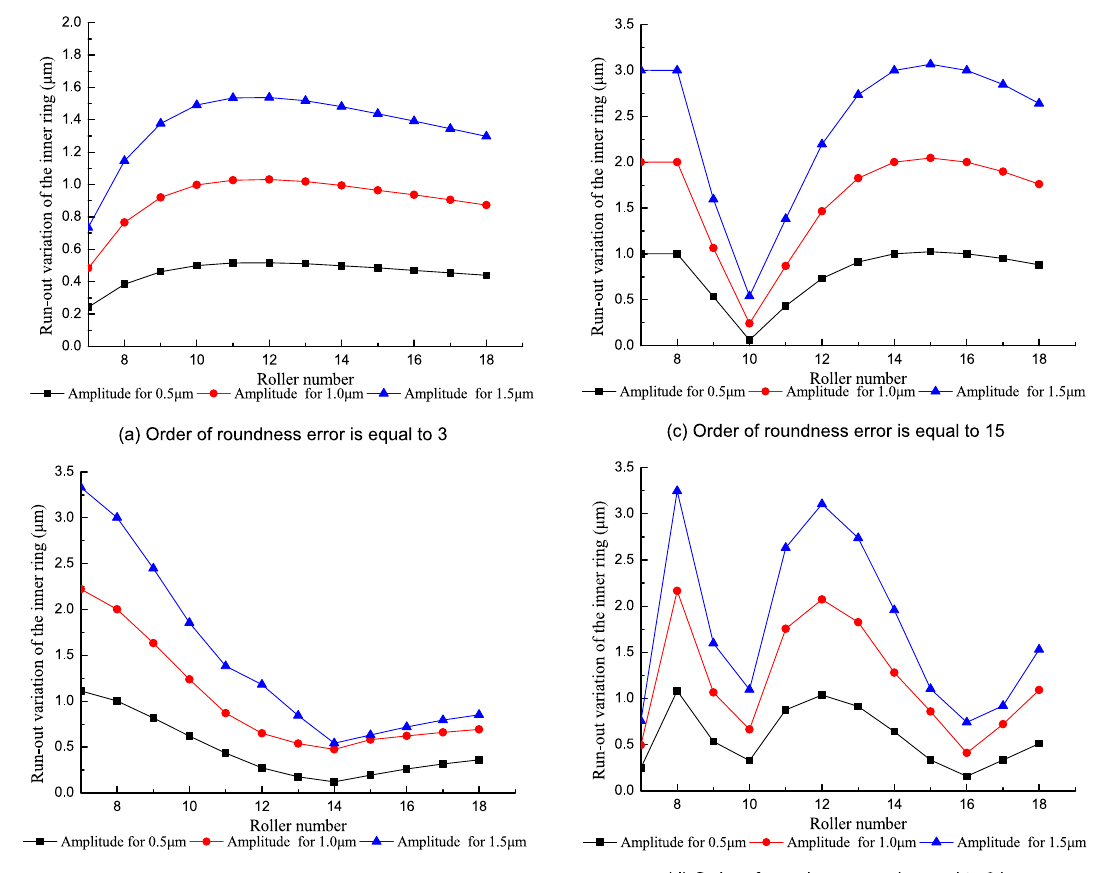
Figure 16. Effect of the roller number on the run-out variation of the inner